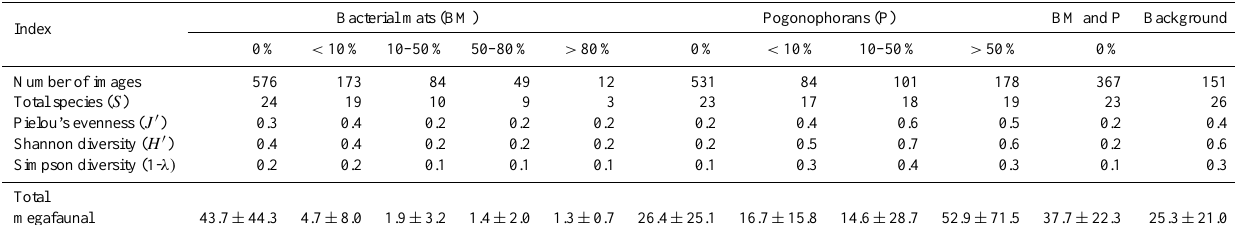
Table 3. Indices of megafaunal diversity and megafaunal density (ind.m − 2 ) in areas of different coverage by bacterial mats and pogonophorans inside the HMMV caldera (OFOS transects I, II and III combined) and the background (OFOS transect IV).